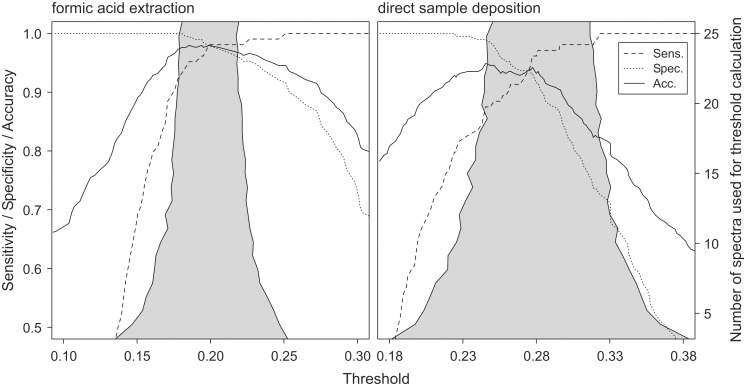
Performance of isolate classification by whole spectrum similarity to reference spectra.Accuracy, sensitivity and specificity for the classification of study isolates by Jaccard’s distance to TY-2482 reference spectra as a function of the selected threshold. Grey areas represent bootstrap estimates of 95% confidence intervals for thresholds derived from the distribution of distance values among outbreak isolate triplicate spectra.